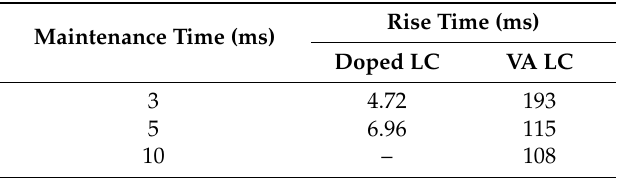
Figure 6. Optical transmittance of 0.1 wt %-gelator-doped LCT-06441 and VA host LC cells under a step-voltage driving scheme with a step maintenance time of 3 ms. Table 1. Rise times of 0.1 wt %-gelator-doped and VA LCT-06441 cells under a step-voltage driving scheme with various step-voltage maintenance